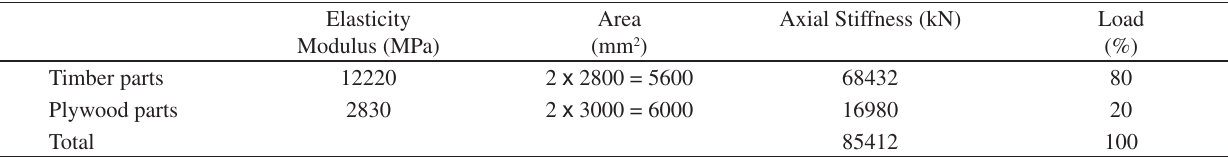
Table 1. Distribution of load among timber and plywood parts at the low end of the specimen.